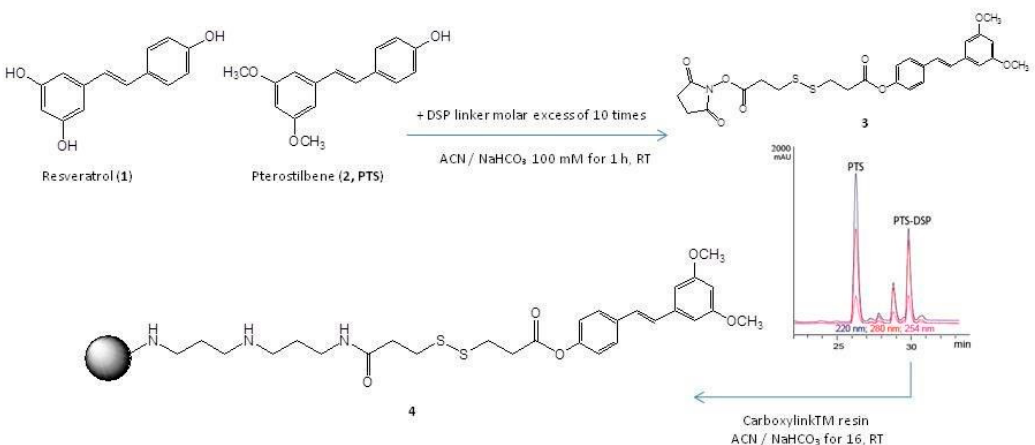
Figure 1. Chemical structure of resveratrol ( 1 ) and pterostilbene (PTS) ( 2 ). Reaction between PTS and the dithio-bis-succinimidyl-propionate (DSP) linker providing a covalent adduct ( 3 ). RP-HPLC-UV purification of 3 and reaction with Carboxylink resin, giving rise to the fishing bait ( 4 ).